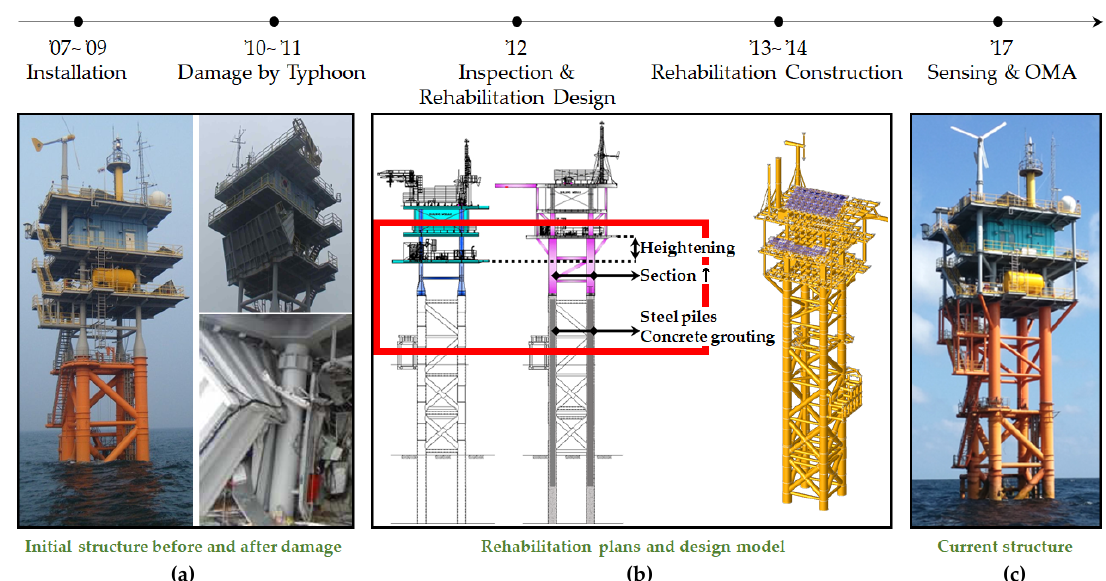
Figure 2. Installation, damage, and rehabilitation history of Gageocho ORS. ( a ) Initial structure be- fore and after damage [13] ( b ) Rehabilitation plans [12] and design model [13] ( c ) Current structure